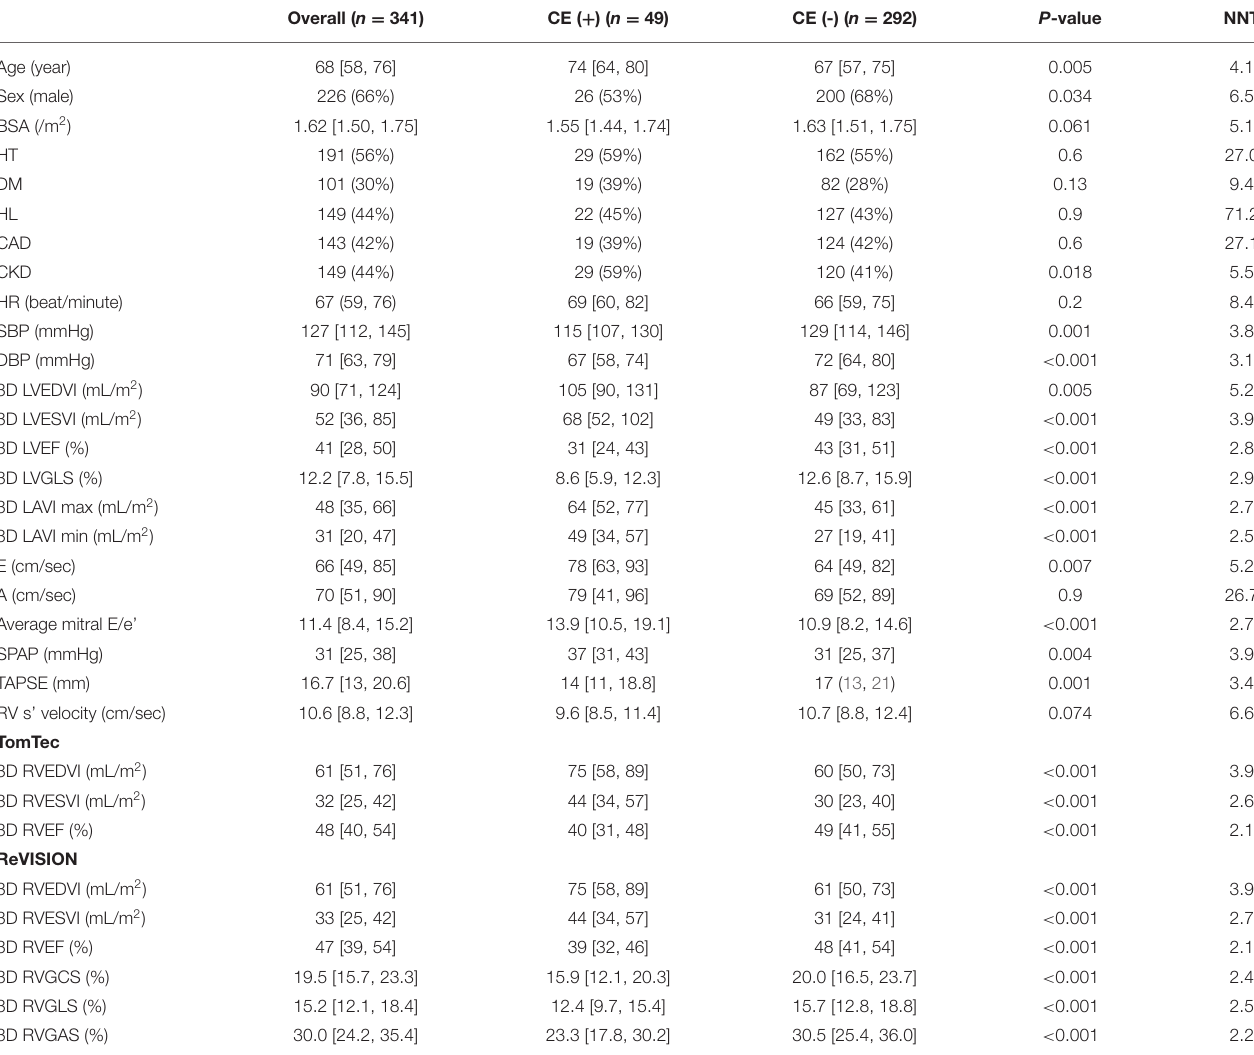
TABLE 2 | Clinical and echocardiography parameters in patients with and without a composite of cardiac events (cardiac death, sustained ventricular arrhythmia, or HF